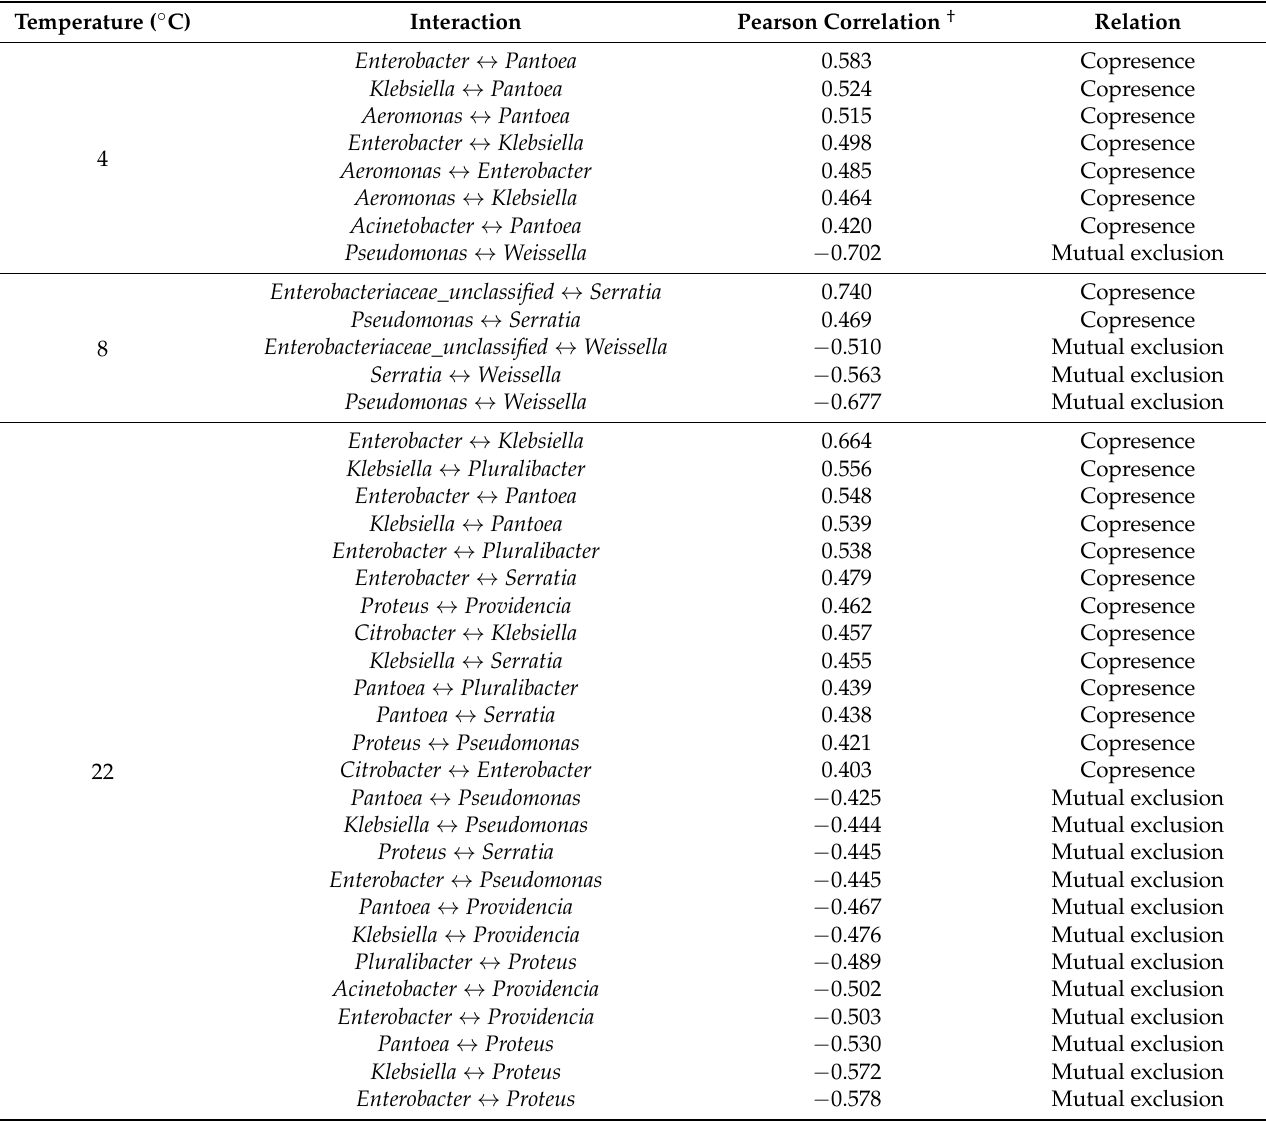
Table 3. Microbial interactions detected by SparCC in the bacterial communities of chicken meat samples stored at 4, 8 and 22 ◦